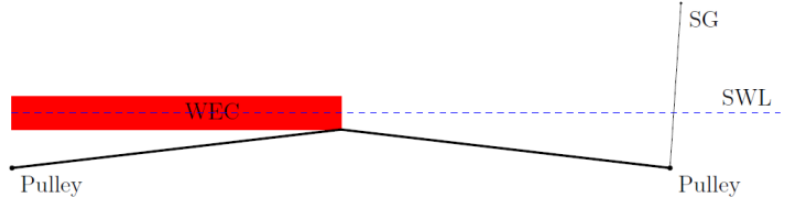
Figure 9. Model mooring load measurement, the load cell “SG” is the strain gauge attached above the basin, used to measure the mooring line loads, the pulleys are attached to the floor of the basin.